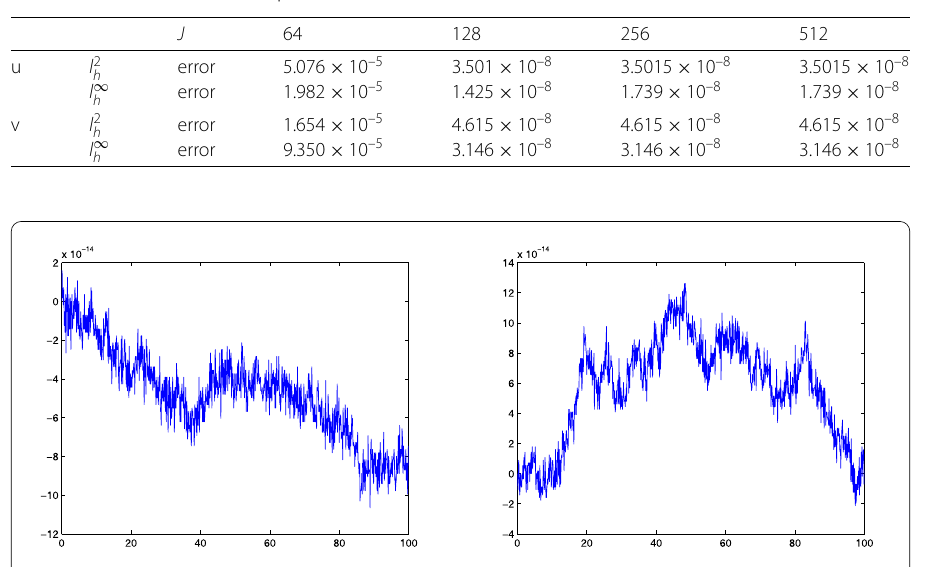
Table 2 Errors and orders in space for τ = 0.001, t = 1